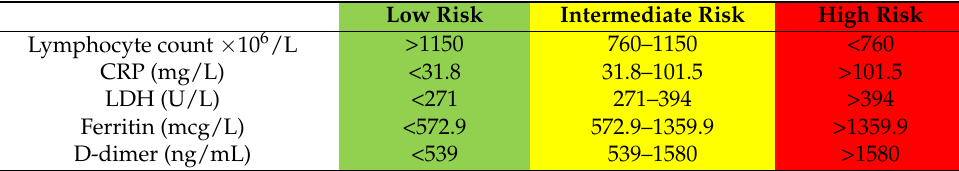
Table 1. Categories of risk.